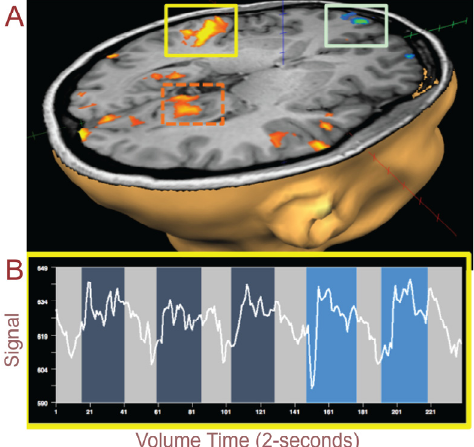
Figure 1. ( A ) Auditory cortex (yellow box) shows an increase in blood-oxygen-level-dependent (BOLD) signals while listening to the music to induce a trance state compared to no music. The light green box surrounds the orbitofrontal activation. The orange dashed box highlights the area prostriata in the functionally defined region. ( B ) BOLD signals extracted from the auditory cortex (yellow box above) show increased signals during music with the last two blocks showing an in- crease in trance perception, i.e., P[high] . in trance perception, i.e., P[high]